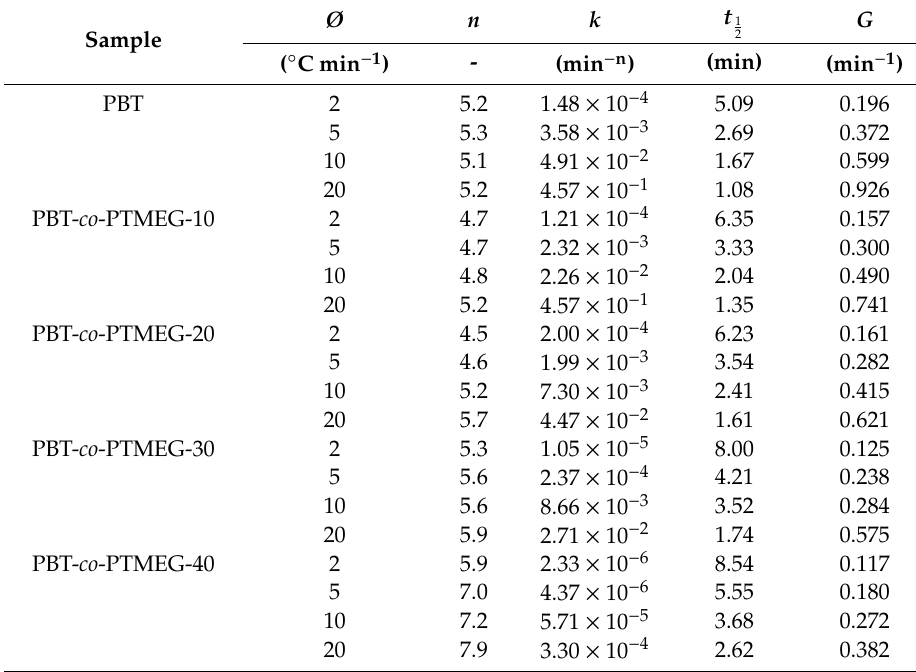
Table 3. Avrami analysis for nonisothermal crystallization and half-time of crystallization for PBT and PBT- co -PTMEG copolymers at di ff erent PTMEG contents.